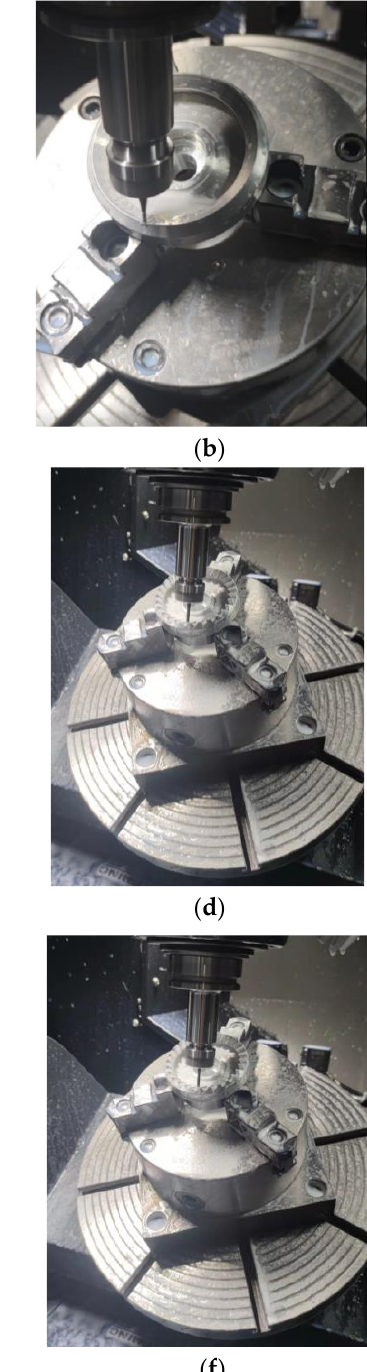
Figure 14. Detailed data about the workpiece.